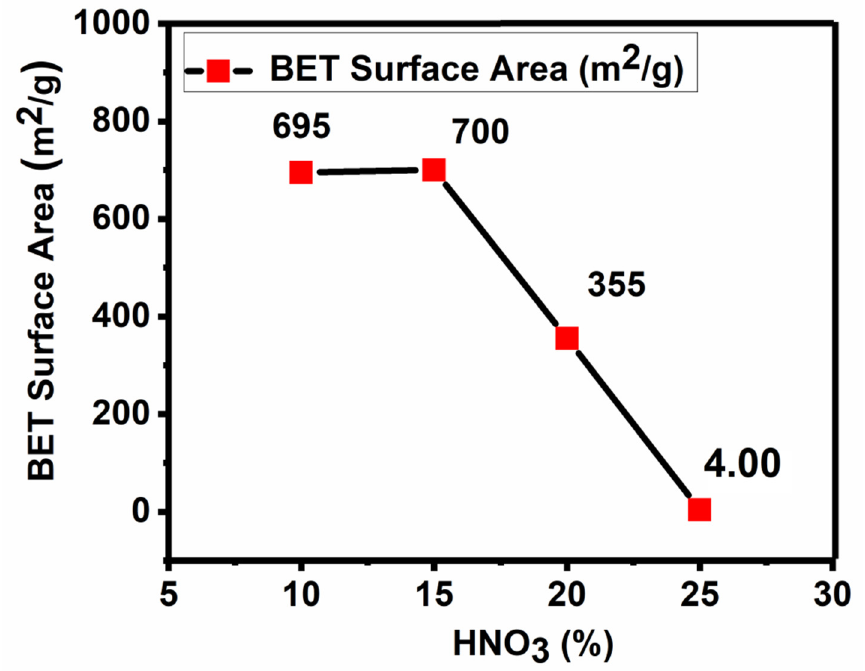
Figure 1. BET Surface area of the FAC prepared at different percentages of nitric acid.